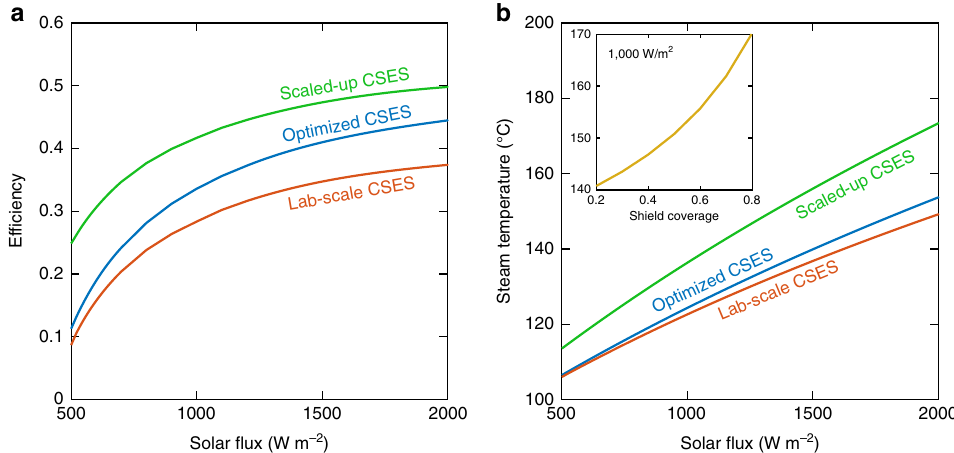
Fig. 7 Performance of optimized and scaled-up contactless solar evaporation structure. a Steady-state ef fi ciency as a function of the incident solar fl ux for as-tested lab-scale CSES, optimized CSES and scaled-up CSES as predicted by the numerical model. b Superheated steam temperature as a function of the incident solar fl ux for each design as predicted by the numerical model. The inset shows the effect of radiative shielding (see Supplementary Note 10 and Supplementary Fig. 12) on the steam temperature of the scaled-up design operating at one sun. The optimized and scaled-up designs utilizes a copper foam in lieu of the RVC foam to reduce the absorber/emitter temperature gradient. For the scaled-up design, it is assumed that the device can be made large enough such that side losses can be neglected and that the superheater effectiveness can be brought to